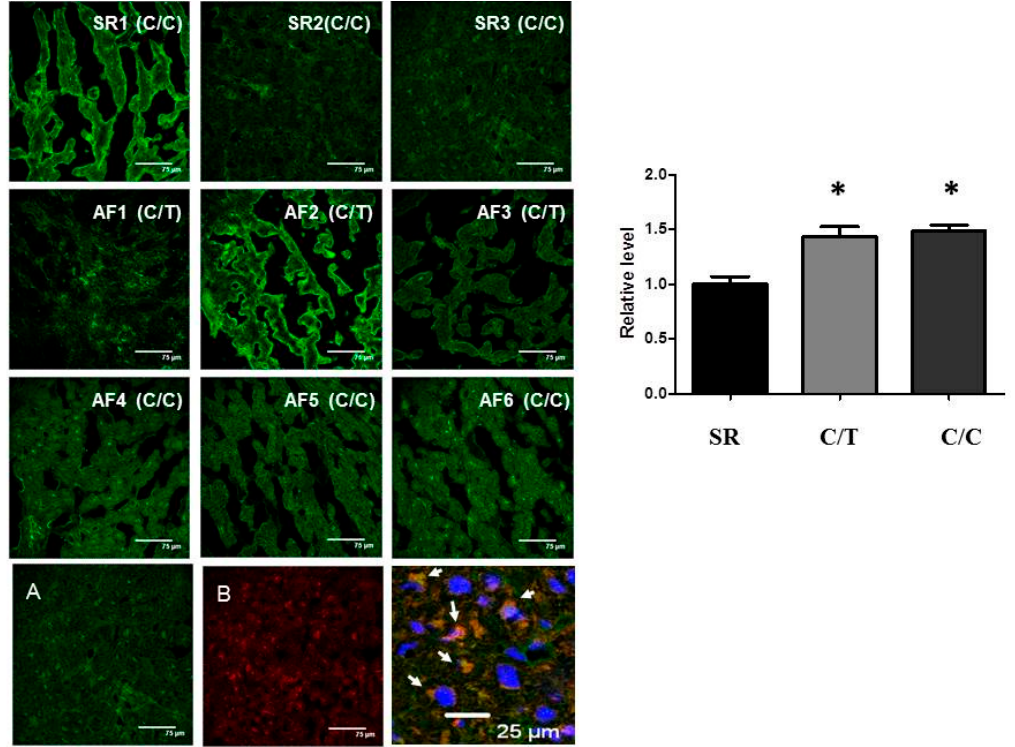
Figure 4. SNP rs3918242 with MMP9 expression in atrial tissues. Representative confocal images show the expression of MMP9 in the atria of six AF patients and three controls (sinus rhythm subjects [SR]). All three controls and three of six AF patients are wild type (CC) for SNP rs3918242. The other three AF patients are heterozygous (CT) for SNP rs3918242. Relative intensity of MMP9 measured in the α -actin-expressing areas was quantified ( right ). ( Bottom ) Co-localization (arrow) of MMP9 with α -actin in cytoplasm of atrial myocytes: ( A ) stained with anti-MMP9; ( B ) stained with anti- α -actin; and ( C ) magnified and merged image of ( A , B ) plus nucleus stained with 4 ′ ,6-diamidino-2-phenylindole (DAPI). At least five random fields were chosen to observe >30 myocytes with scanning and averaging. Data are expressed as mean ± SE; * represent p < 0.05, the significant difference compared with SR controls.